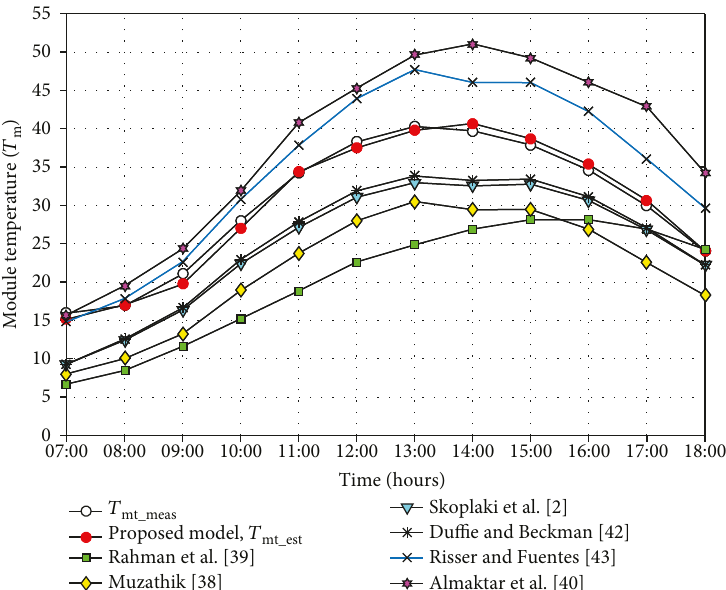
Figure 11: Proposed model estimation versus measured data and other existing model module temperature values of thin fi lm module during